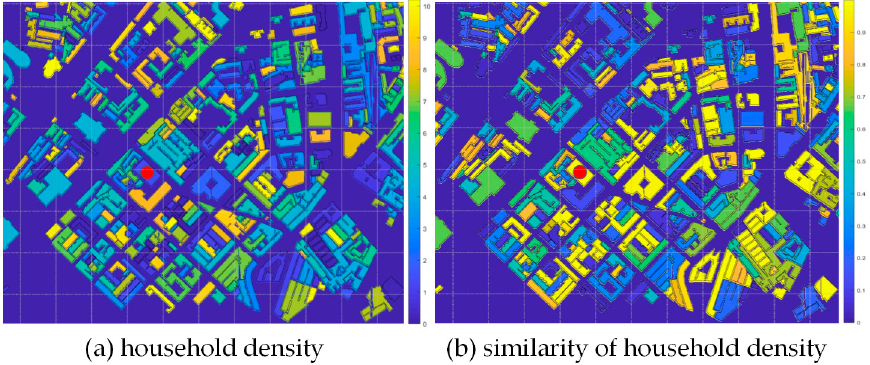
Figure 4. Environmental similarity of buildings.